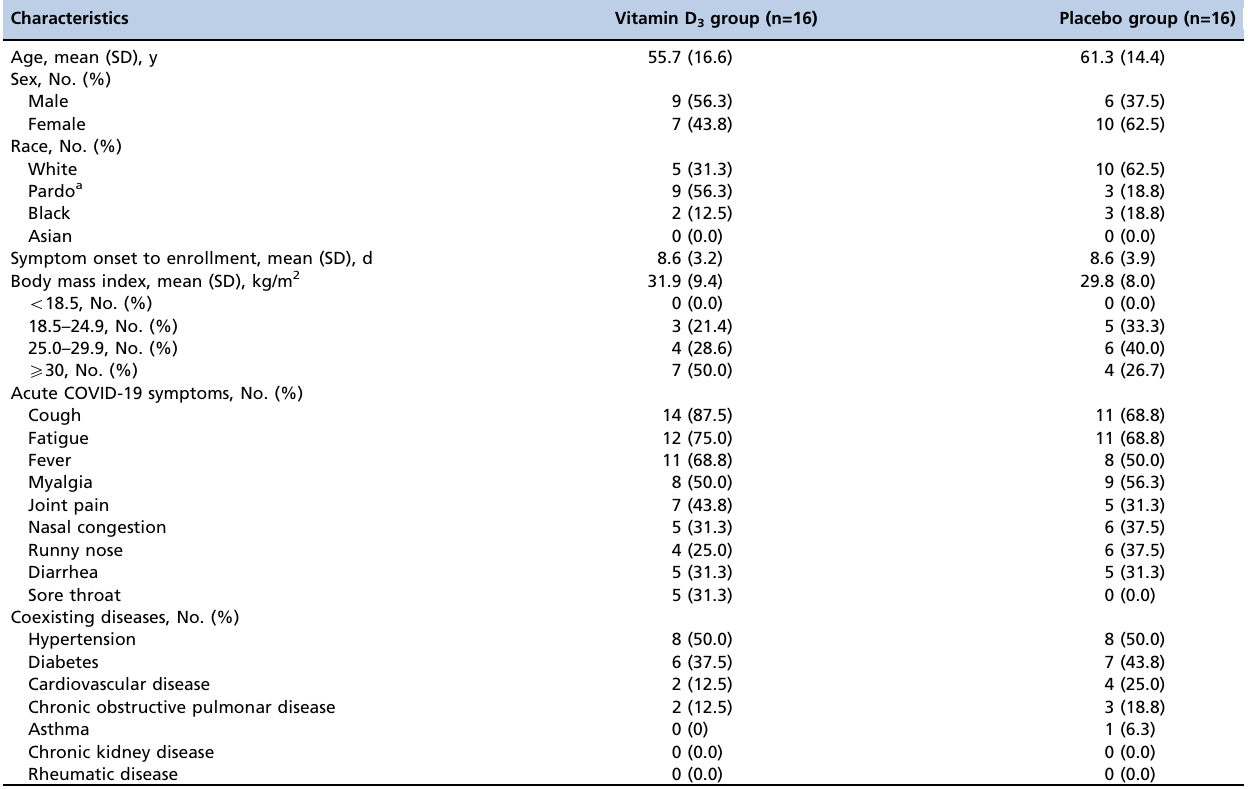
Table 1 - Baseline demographic and clinical